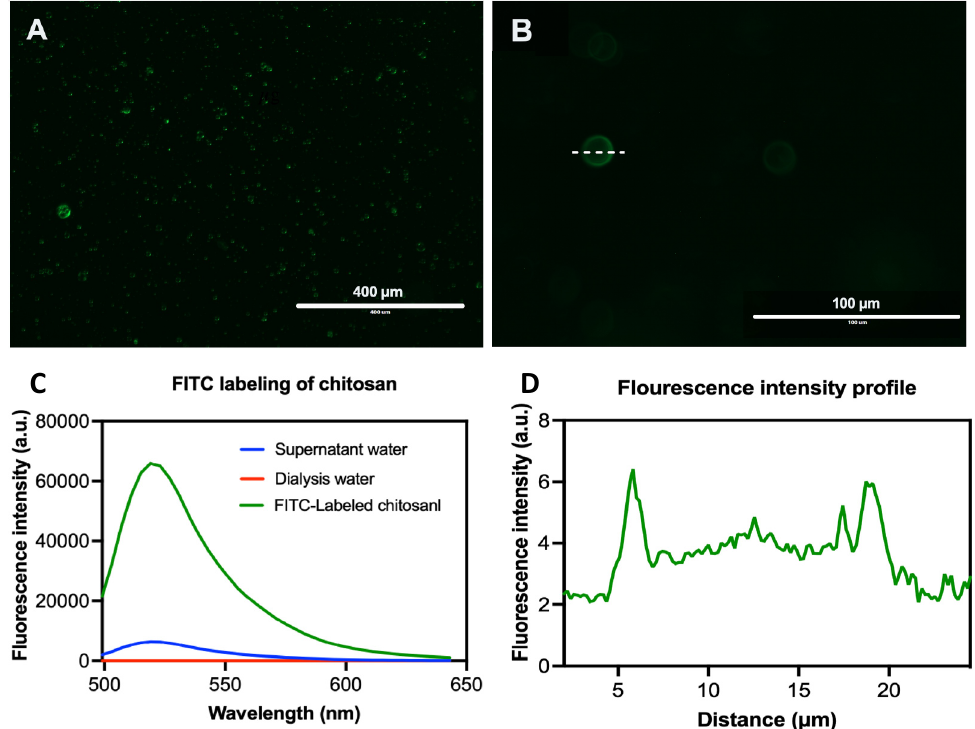
Figure 8. Representative fluorescence images of FITC-labeled CS-PLGA particles ( A , B ). FITC labelling evaluation ( C ) and fluorescence intensity profile across the center of the particles ( D ).